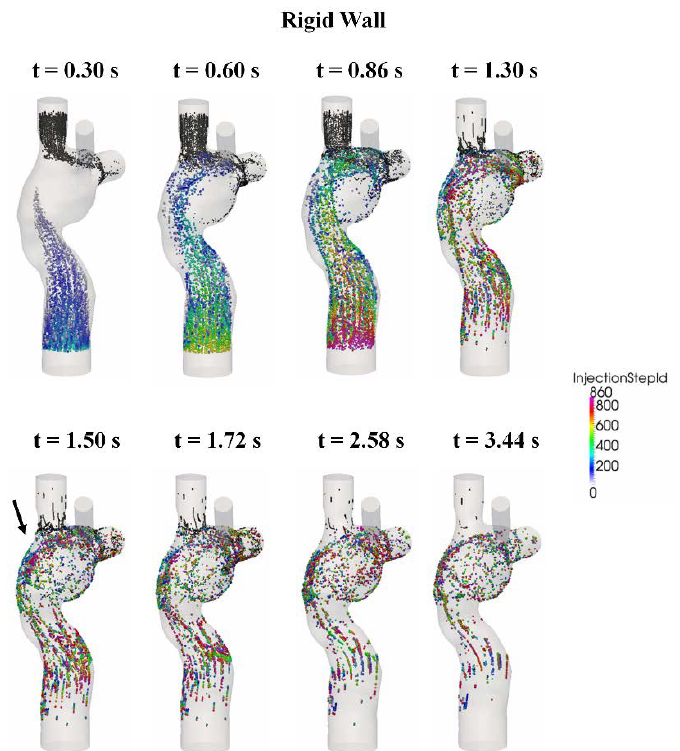
Figure 12. Progression of the particles seeded at the FP from the rigid wall simulation. The FP particles are color-coded by their seeding time step. SVC particles are colored in black. FP: Fontan pathway, SVC: superior vena cava.